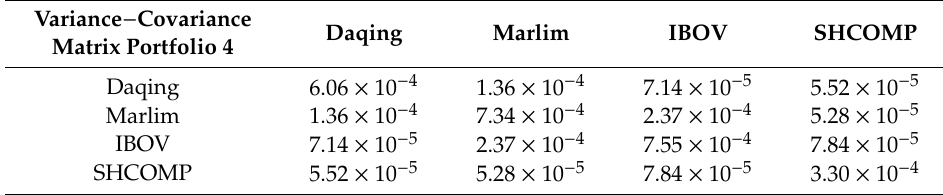
Table A28. Maximum Likelihood Variance–Covariance Matrices for portfolio 4: Daqing, Marlim, IBOV, SHCOMP. Elaborated by authors with data from Bloomberg.